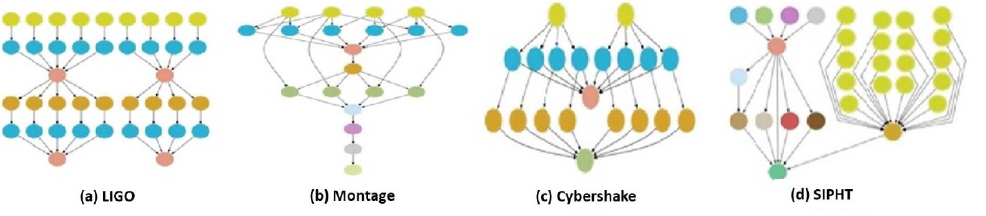
Figure 1. Examples of scientific workflows